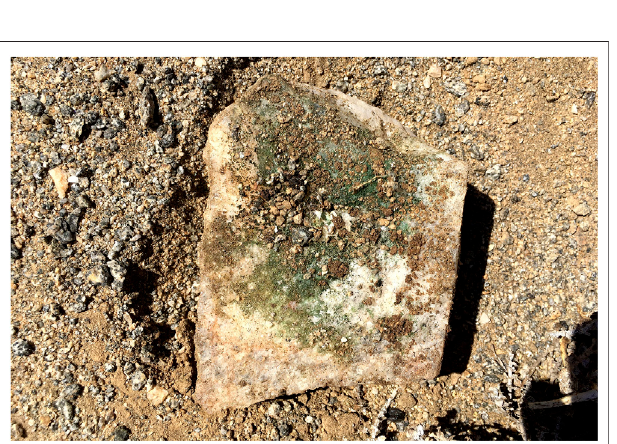
FIGURE8| Hypolithicbio fi lmsunderquartzstonesoftheCoastalRange south of the city of Antofagasta.